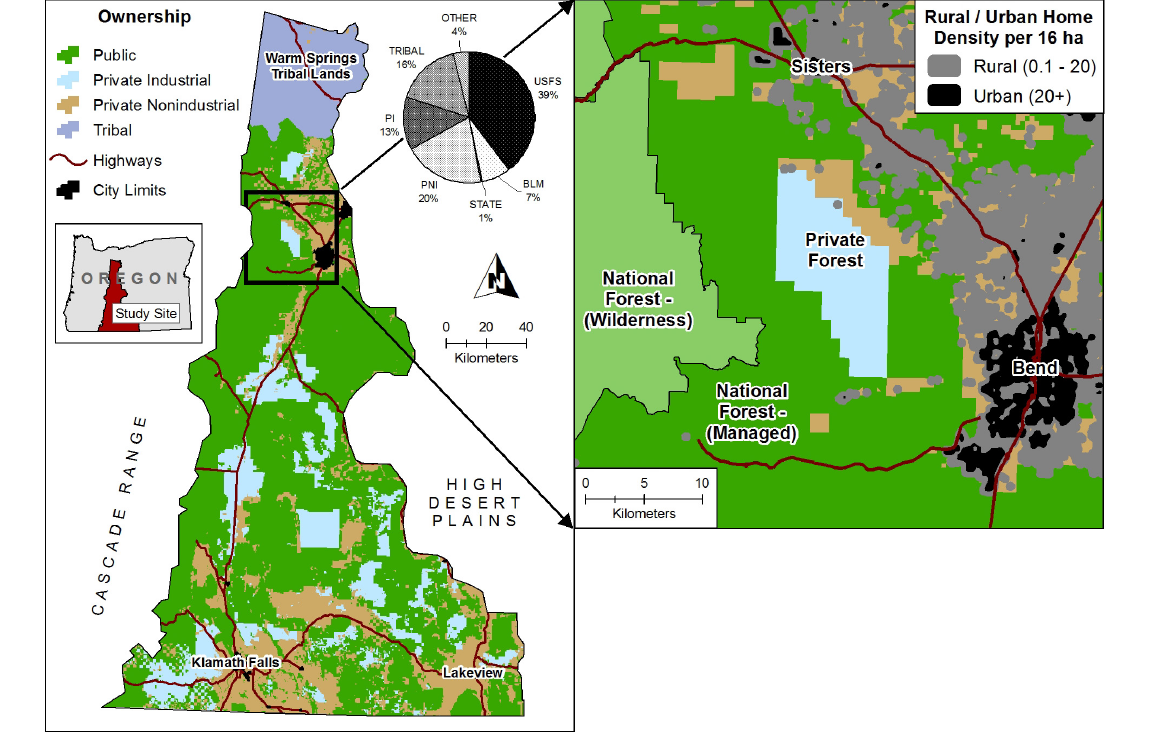
Fig. 2. Ownership across the study area and home density in a sub-area where the wildland-urban interface is a prominent component of the landscape. Source of housing data: Oregon Department of Forestry